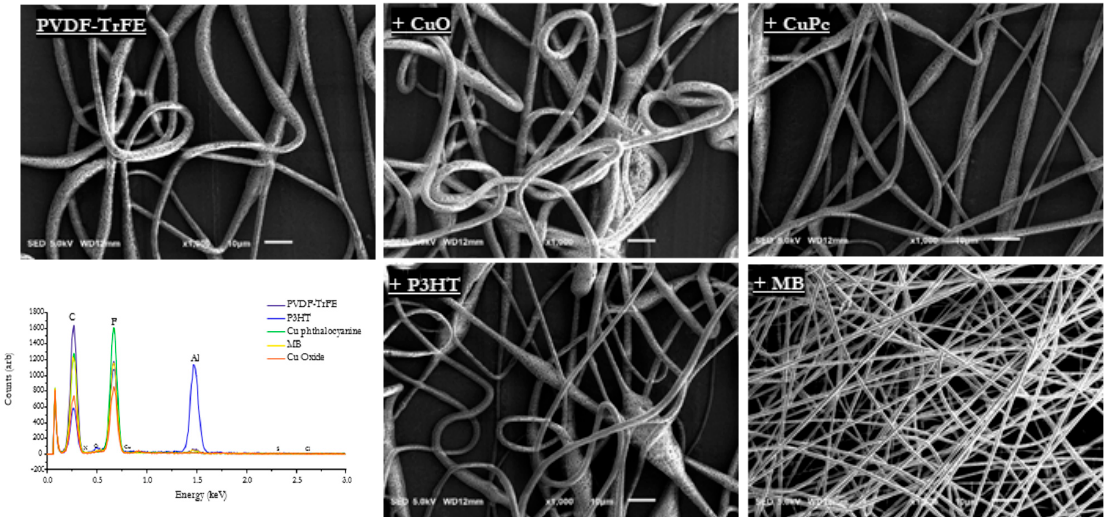
Figure 2. Comparison of pure and composite PVDF-TrFE nanofibers: SEM and EDS analysis.